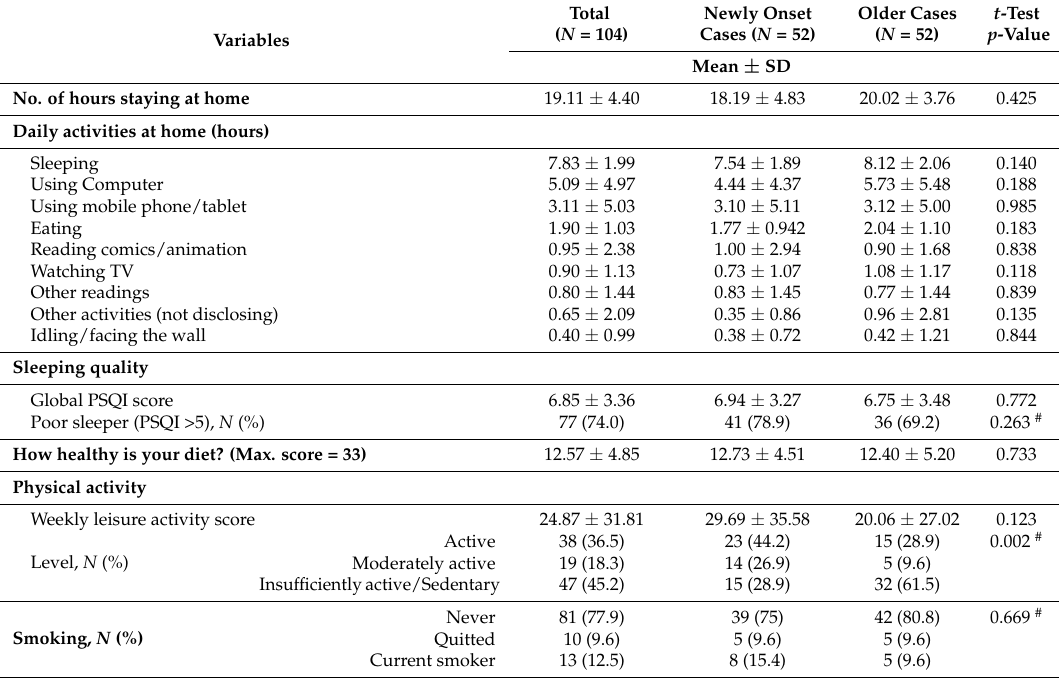
Table 2. Lifestyle living with the hikikomori of Hong